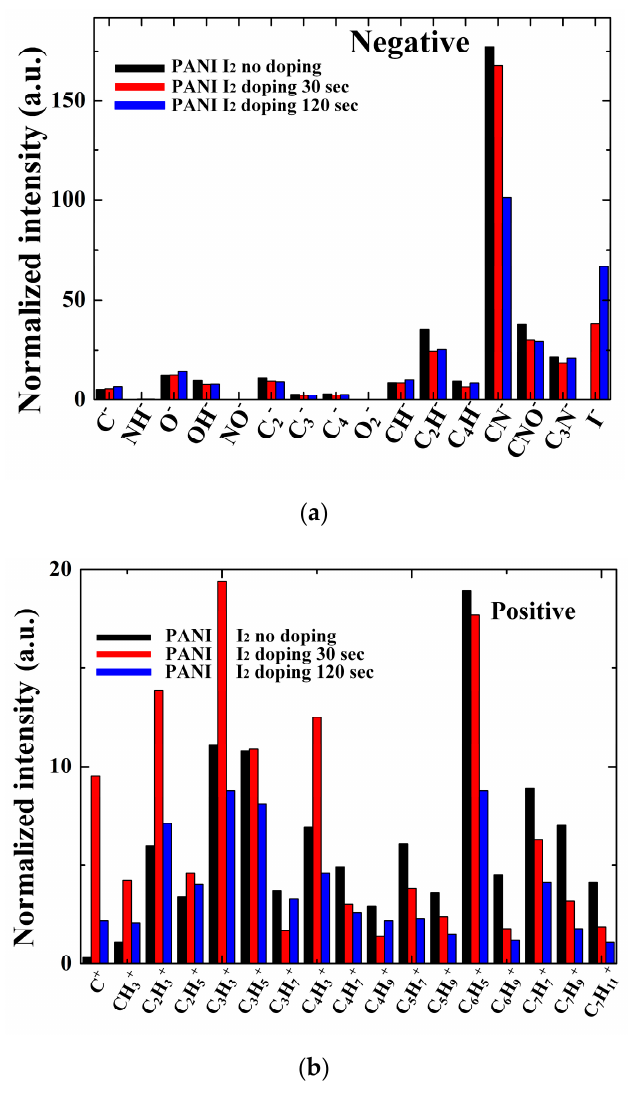
Figure 9. Comparison of normalized intensities of: ( a ) negative-ion ToF-SIMS; and ( b ) positive-ion ToF-SIMS on surface of PANI films when using advanced APPJs device without I 2 doping, with 30 s I 2 doping, and with 120 s I 2 doping following deposition.